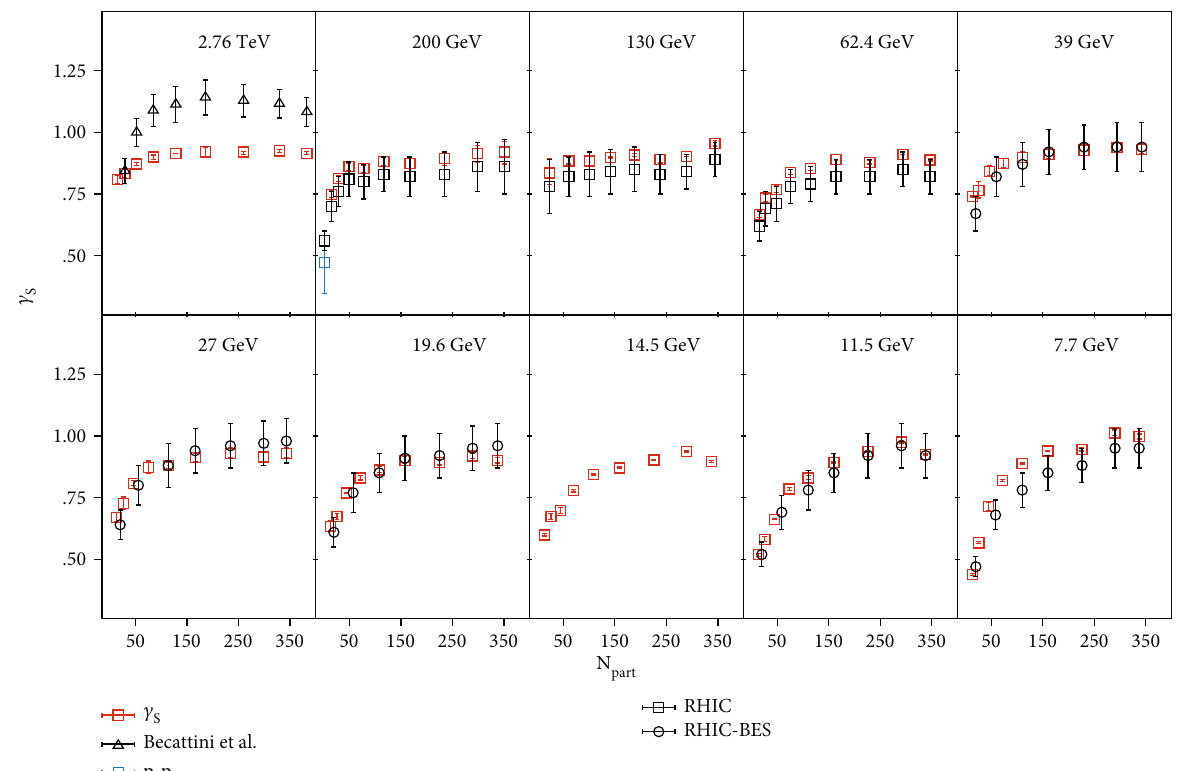
Figure 3: (Color online) variation of γ with N part for representative collision energies. Each column stands for di ff erent collision energy, S ranging from LHC (2.76 TeV) to RHIC-BES (7.7 GeV). Most central collision ( 0 % − 5 % ) is denoted by the highest value of N part , lowest value denotes the peripheral collision ( 70 % − 80 % ). Red square denotes results for Pb-Pb at LHC and Au-Au at RHIC and BES. Blue square points analysis for p - p collision of RHIC-200GeV. Results from available literature have been included in the following Ref. [73] for LHC (black triangle), Ref. [6] for RHIC (black square), and Ref. [66] for RHIC-BES (black